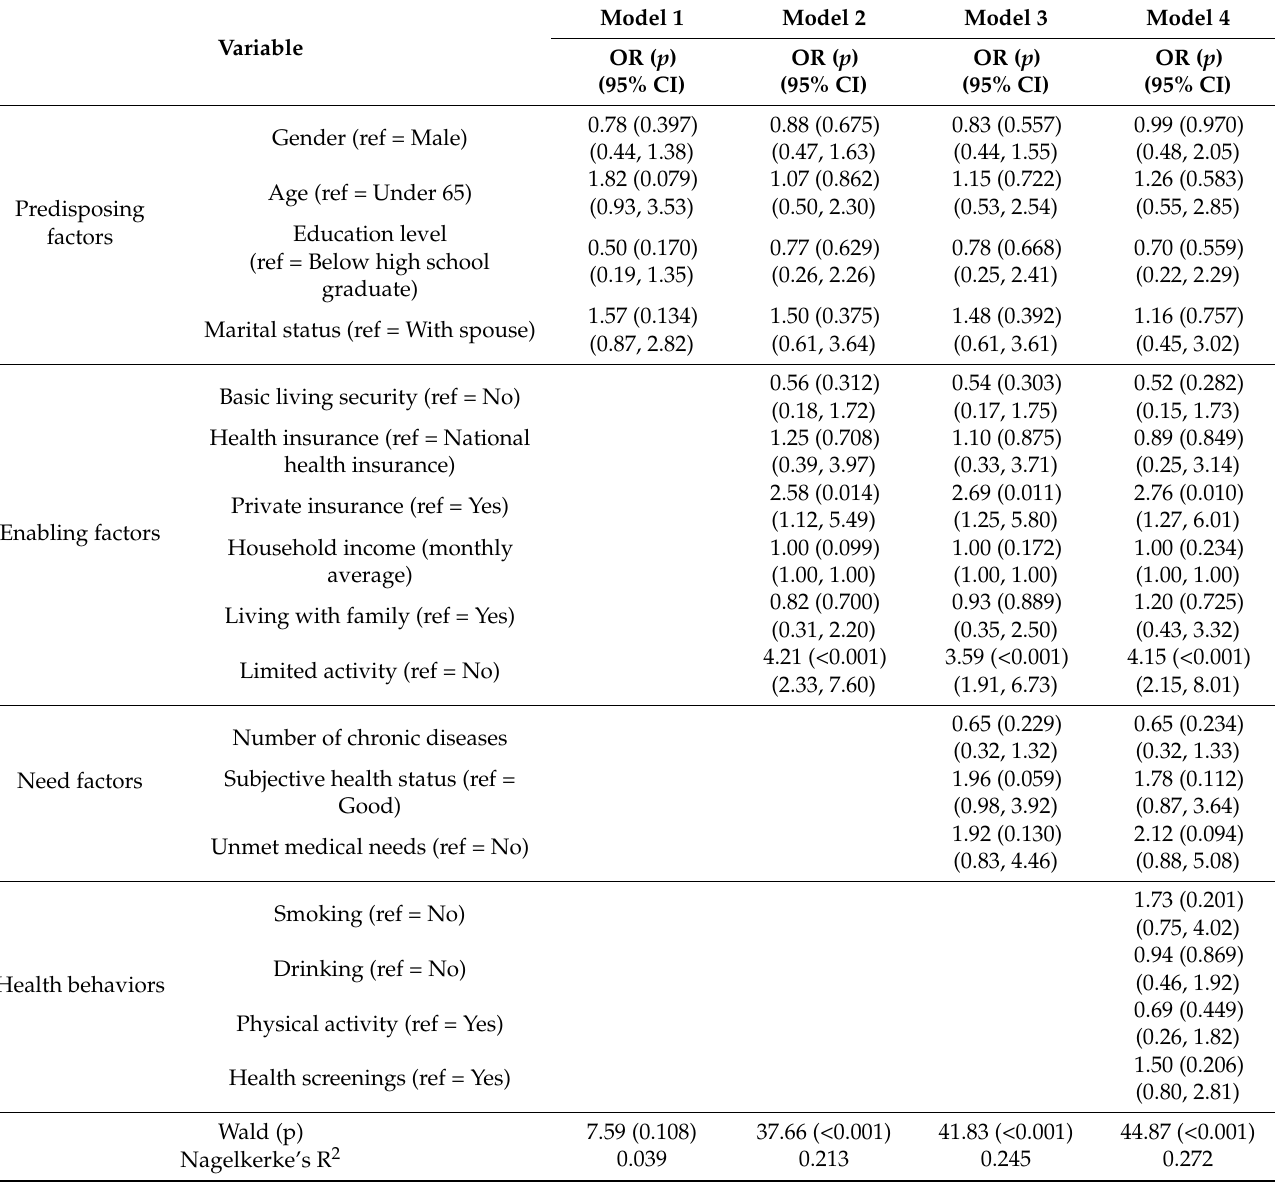
Table 3. Factors affecting self-care dimension of health-related quality of life in patients with multimorbidity according to Andersen’s model (South Korea,